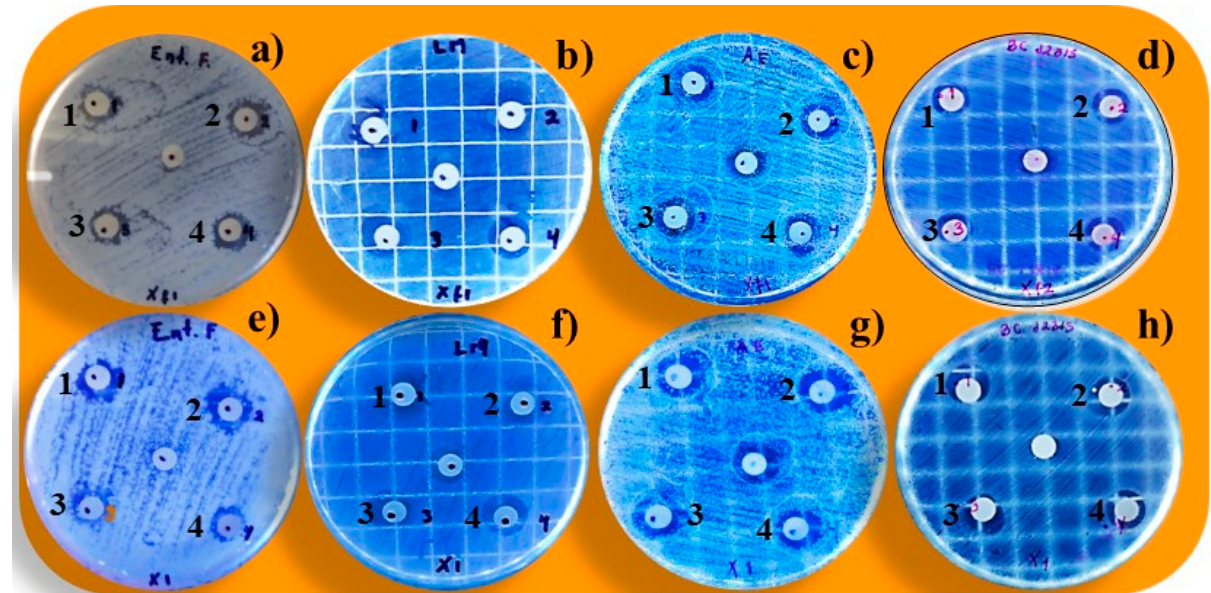
Figure 1. Effect of P-ACGs ( a – d ) and CE ( e – h ) on Gram-positive (( a , e ) Enterococcus faecalis ( b , f ) Listeria Monocytogenes ) and Gram-negative (( c , g ) Aeromonas hydrophila ; ( d , h ) Burkholderia cenocepacia ). Concentration of P-ACGs and CE = (1) 4000 µg/mL; (2) 2000 µg/mL; (3) 1000 µg/mL, and (4) 800 µg/mL.